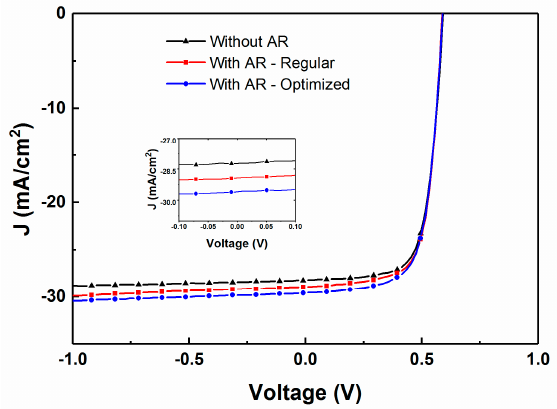
Figure 9. Measured J–V curves for CIGS solar cells with a 1.5 µ m thick absorber and either no AR coating, a 105 nm prior modeled AR coating thickness, or a 95 nm in-situ optimized AR coating thickness.